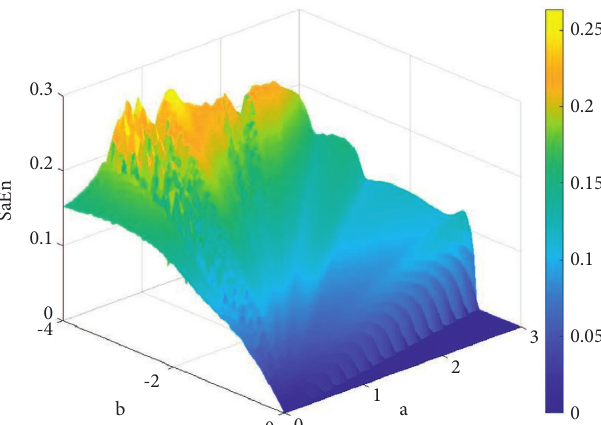
Figure 7: The sample entropy is used for assessing the oscillator’s signals complexities for a range of the system’s parameters. A trend can be seen that decreasing b and increasing a values result in increasing the sample